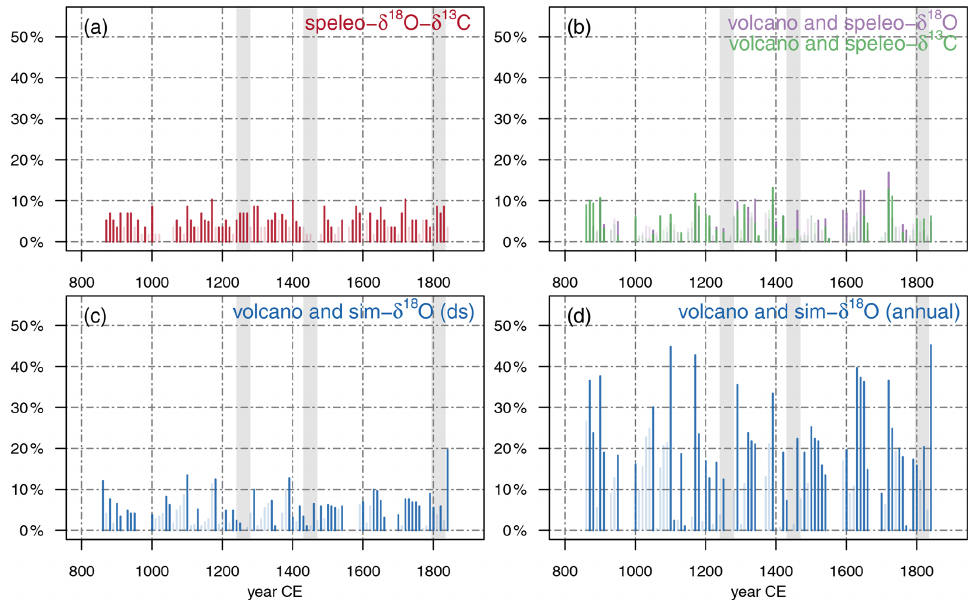
Figure 10. (a) The synchronous extreme events between δ 18 O speleo and δ 13 C speleo (red), (b) the synchronous events between the speleothem isotopes (oxygen purple and carbon green) and volcanic eruptions as reconstructed by Crowley and Unterman (2013) or Gao et al. (2008) (de- picted in Fig. 1d), (c, d) the synchronous extreme events between simulated δ 18 O values at the cave locations of all simulations downsampled to record resolution and annual resolution, respectively. Where occurrence of synchronous extreme events is significant with α = 0 . 05, the bars are shown in dark colors, where it is non-significant the bars are shown in transparent colors. The four light grey bars in the background of each plot show areas of high volcanic